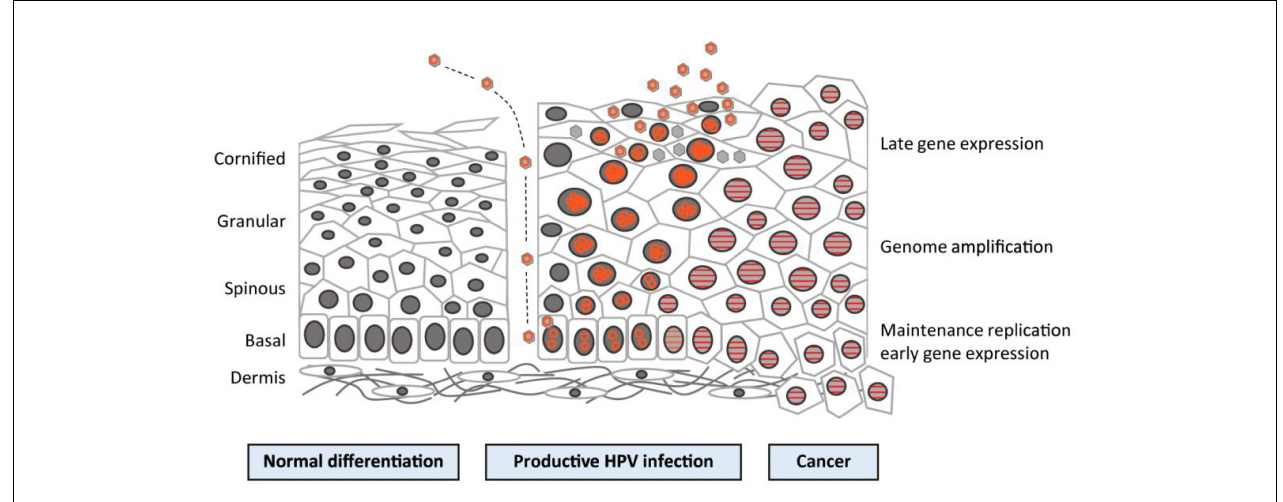
FIGURE 3 | Human papillomavirus (HPV) life cycle and cancer. Cartoon depicting normal stratified cervical epithelium (left), HPV-infected epithelium (center), and HPV-induced cancer (right). Epithelial layers are indicated on the far left, and HPV life cycle stages are indicated on the far right. Episomal genomes are shown as orange circles and integrated genomes are shown as orange stripes. (Left) Normal keratinocyte differentiation: basal cells divide and daughter cells migrate upward, beginning the differentiation process. As differentiation proceeds, cells exit the cell cycle. Fully keratinized squames slough off from the apical surface. (Middle) Productive HPV infection: HPV virions gain access to basal cells via microwounds. The viral genomes migrate to the nucleus, where they are maintained at ˜100 copies/cell. As daughter cells begin differentiation, viral genomes are amplified. Cell nuclei are retained and chromatin is activated to support viral DNA replication. (Right) Cancer: viral genomes often integrate into the host genome and E6/E7 expression is increased, leading to enhanced proliferation and the accumulation of cellular mutations. Cellular differentiation is lost, and cancerous cells invade into the dermal layer as well as into neighboring tissues (Langsfeld and Laimin,